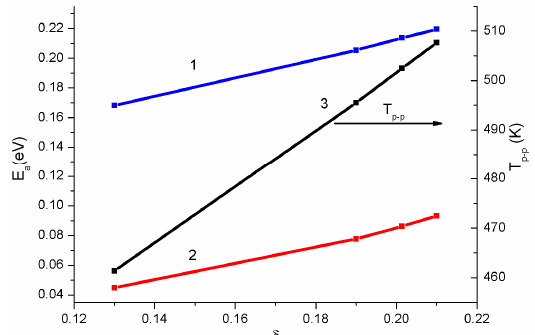
Figure 6. Dependencies of the activation energy E a : (1) is the temperature region below the electronic transition and (2) is the high-temperature region, and (3) semiconductor–semiconductor transition temperature T p-p on the oxygen nonstoichiometry index.